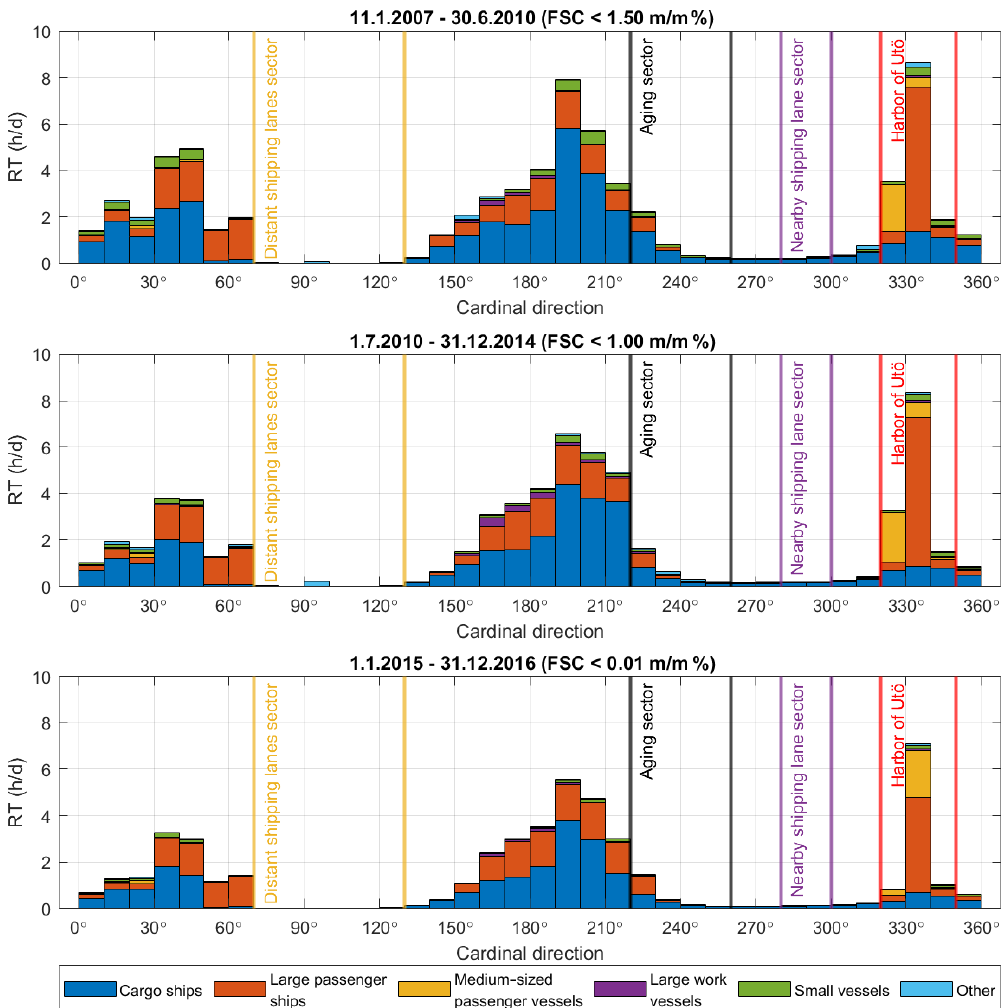
Figure 2. Ship types around Utö during the different fuel sulfur content (FSC) restriction periods: (a) FSC < 1.50 m/m % (11 January 2007– 30 June 2010), (b) FSC < 1.00 m/m % (1 July 2010–31 December 2014), and (c) FSC < 0.10 m/m % (1 January 2015–31 December 2016). Ship types were classified as cargo ships, large passenger ships, medium-sized passenger vessels, large work vessels, small vessels, and other. On the y axis, RT is the average residence time in hours per day of ships in the category in each of the 10 ◦ sectors given on the x axis. The distant shipping lanes sector, aging sector, nearby shipping lane sector, and harbor of Utö are marked using pairs of vertical